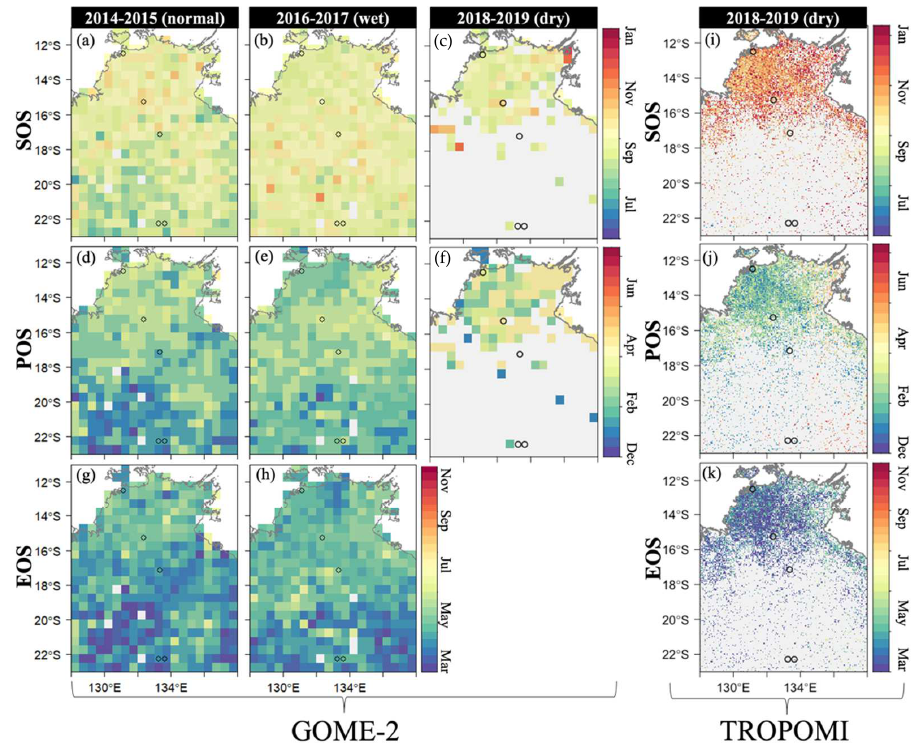
Figure 6. Spatial patterns of vegetation phenology based on ( a – h ) GOME-2 SIF and ( i – k ) TROPOMI SIF over the NATT study area across three representative hydrological years, 2014–2015 (normal year), 2016–2017 (wet year), and 2018–2019 (dry year). The filled pixels (grey shaded areas) are either water body or without detectable phenology. SOS: the start of growing season; POS: the peak of growing season; EOS: the end of growing season. Blank circles represent 5 selected eddy covariance flux tower sites.